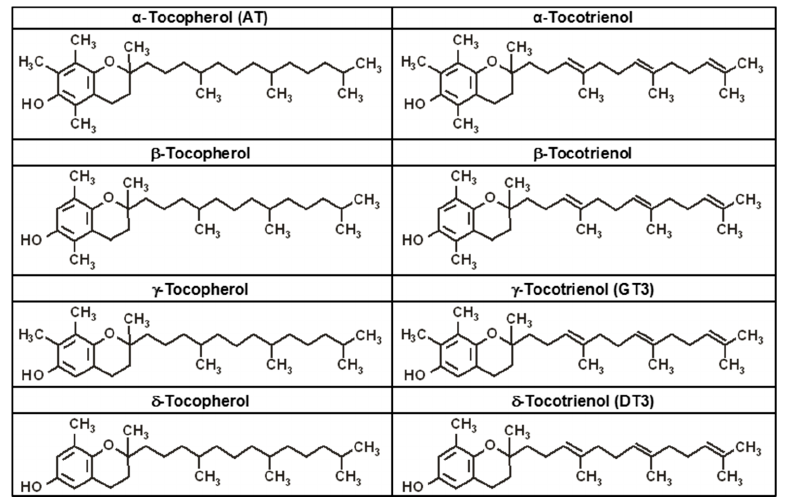
Figure 1. Chemical structures of all members of the vitamin E family